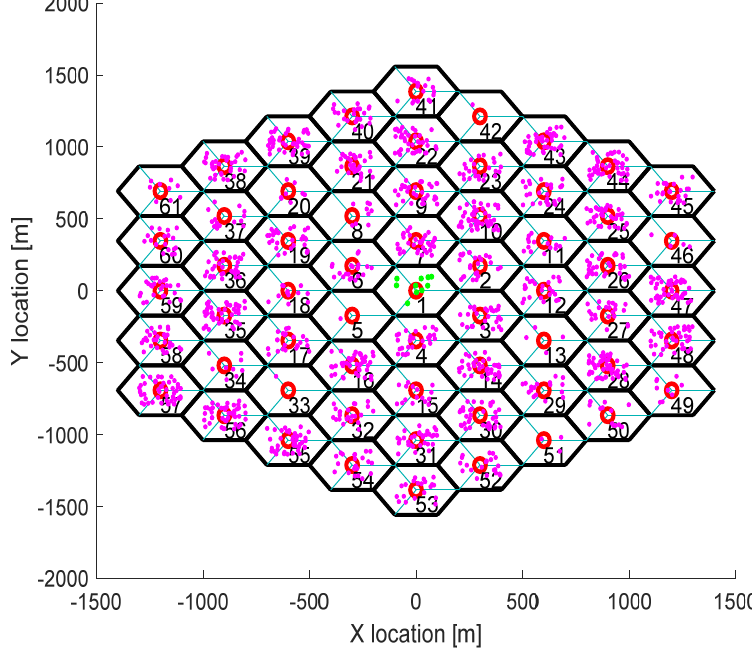
Figure 2. Network deployment of various hexagonal cells, each cell containing three sectors. To represent the environment of the real 5G network, initially, a number of mobile utilizers were created with random coordinates inside the hexagonal boundaries of each cell. The 200 randomly distributed utilizers are generated throughout every hexagonal cell. The utilizers’ number periodically and randomly changed in each cell during the simulation cycles. This is means that the load traffic for every eNB was periodically and automatically changed to represent this real environment. This is taken into account in the simulation model, developed in order to simulate the arbitrary generation of load traffic during the simulation and to fully enable the acceptable control functions in the target cell during user mobility. The proposed algorithm has been evaluated and validated through the simulations using the 5G network. The average values taken from 15 users represent all results considered in the measurements throughout this work. The 15 users were randomly generated within cell number 1 in the first simulation period. Initially, every user had various random coordinates in the cell. Each utilizer had a varied path that was parallel to another utilizer’s measure, since user mobility is directed in one direction. This means that all utilizers will move parallel to each other user in one direction. The directional mobility model has been suggested for all mobile device users measured across the network that are permitted to move in one direction only. This will increase the accuracy of the results since performance is measured independently for every utilizer in each simulation period. This is accomplished in 5 s through their mobility inside the cells,